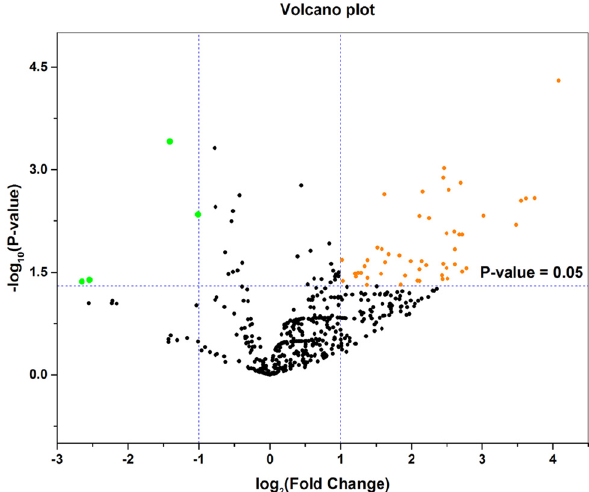
Figure 3: Volcano plot of the DE - miRNAs. The black points represent genes with no signi fi cant di ff erence. The orange points represent upregulated genes screened based on the | log FC | > 1.0 and P - value < 0.05. The green points represent downregulated genes screened based on the | log FC | > 1.0 and P - value <